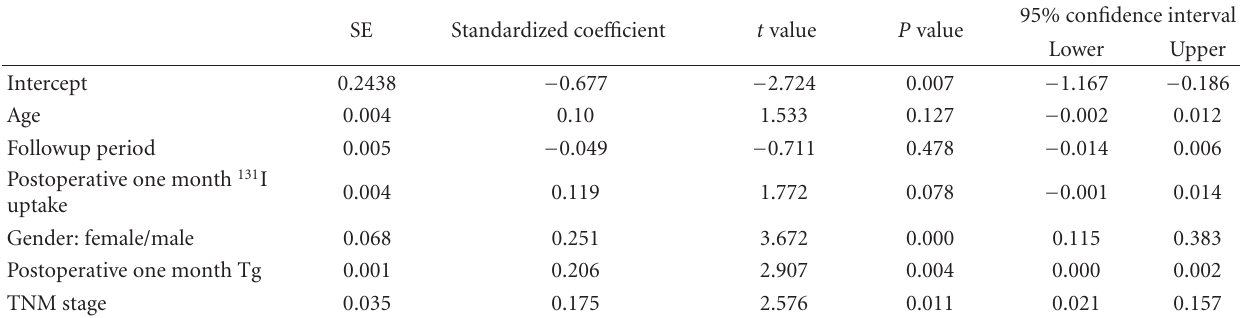
Table 2: Multiple regression analysis for factors associated with postoperative